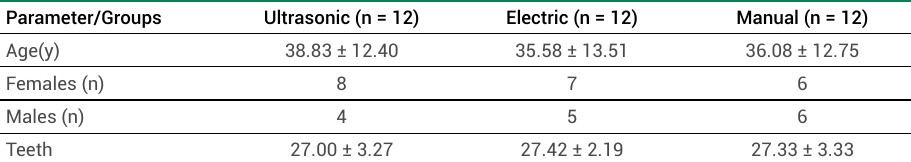
Figure 1. Study Flowchart Table 1. Demographic characteristics of the patients at